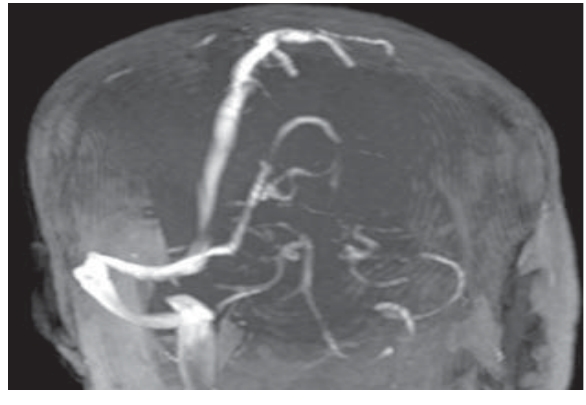
Figure 2. Hypoplastic left transverse sinus and non- visualised internal jugular vein